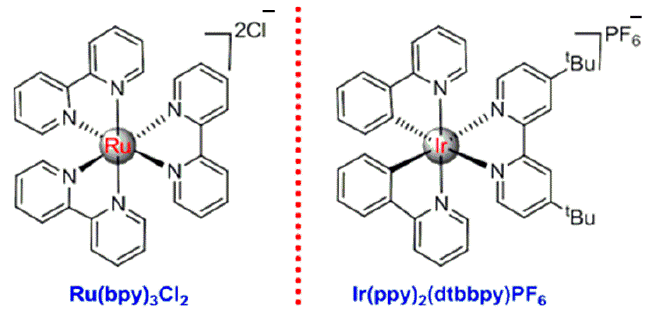
Figure 1. Synthesis of biologically active compounds through C-H/N-H bond activation.